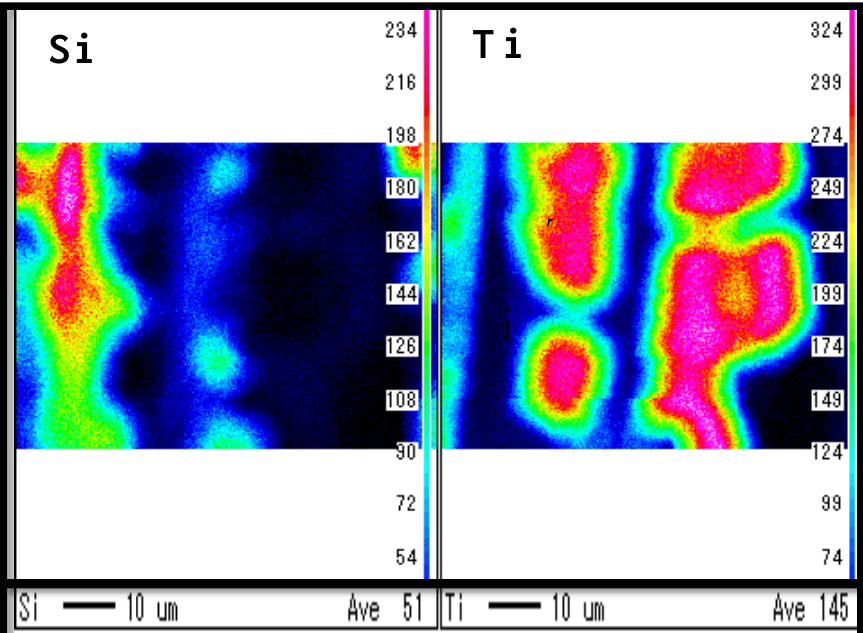
Figure 3. EPMA result of TiO 2 film coated on netlike glass disc.